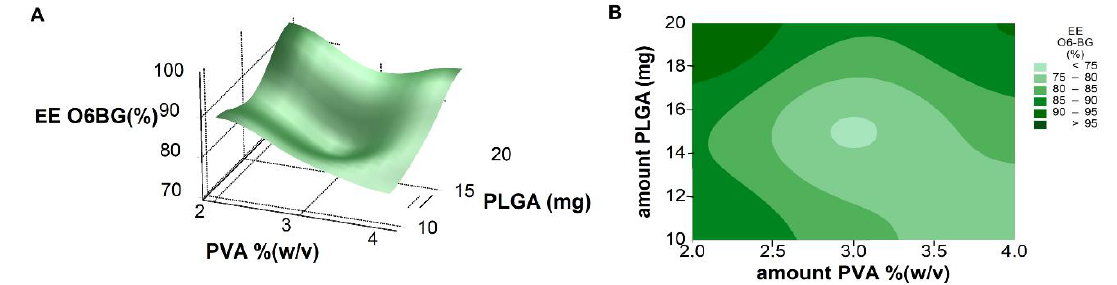
Figure 6. ( A ) Response surface plot and ( B ) contour plot showing the effect of two factors (amount of PLGA and PVA, respectively) on the resulting EE values.